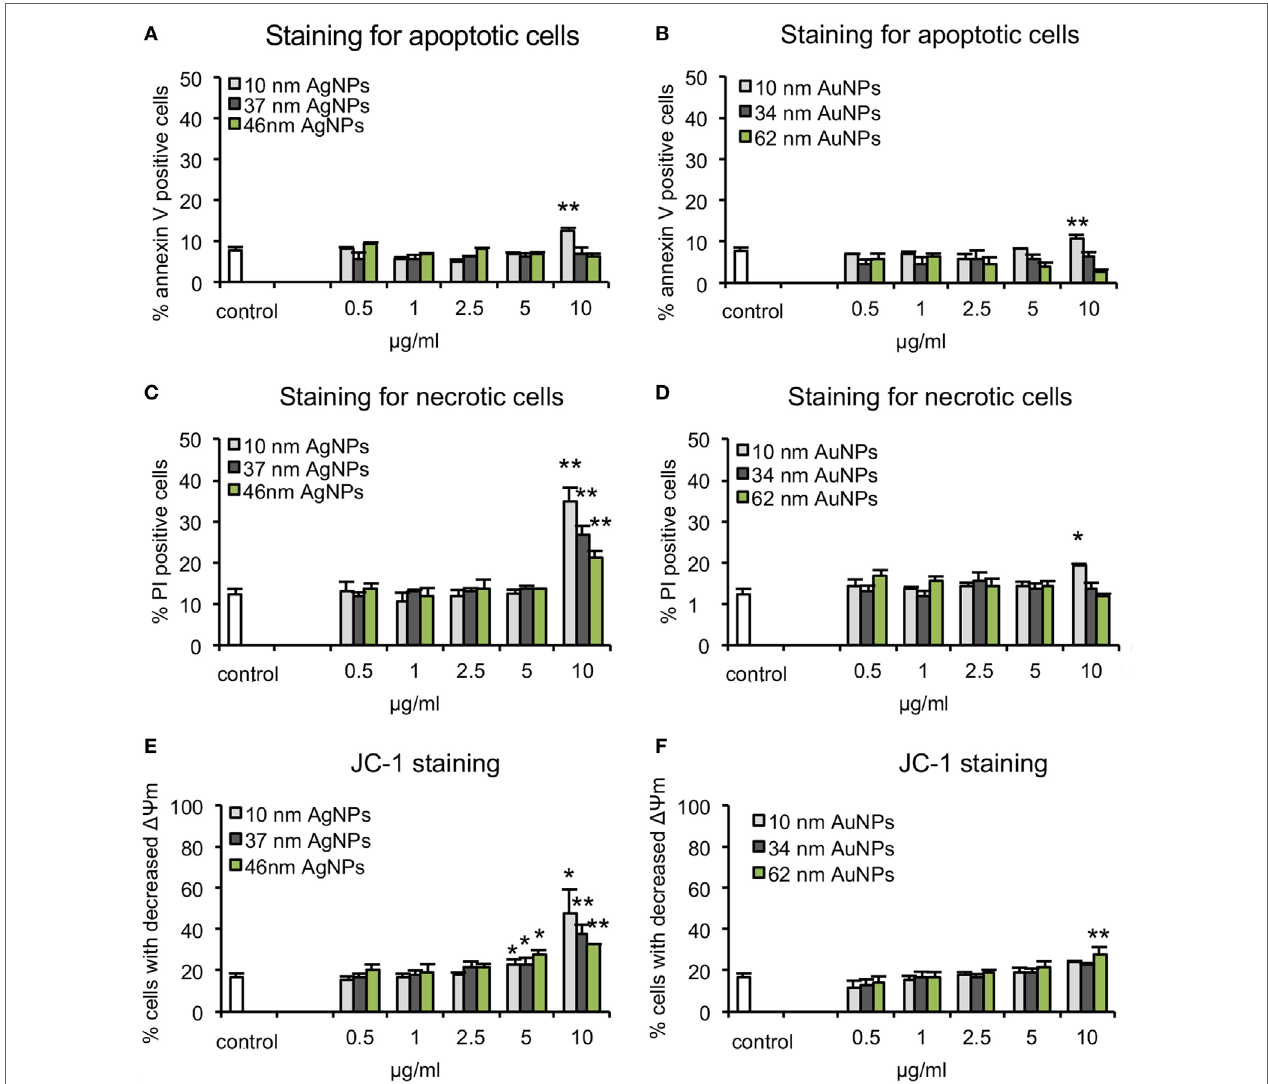
FigUre 2 | Cytotoxicity assays in JAWSII cell line at 24 h of exposure to AgNPs sized 10 nm, 37 nm, and 59 nm, and AuNPs sized 10 nm, 34 nm, and 62 nm at 0.5–10 µg/ml. (a,b) Percentage of annexin V-positive (apoptotic) cells. (c,D) Percentage of PI positive (necrotic) cells. (e,F) Decrease in mitochondrial potential expressed as the percentage of cells with decreased mitochondrial potential Each bar represents the mean from five experiments ( N = 5) ± S.E.M., *Significant differences with p ≤ 0.05, ** p ≤